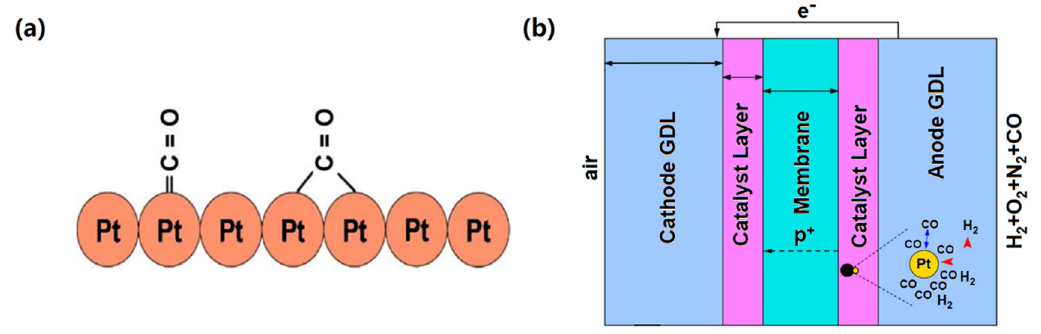
Figure 1. Sketch Map of ( a ) CO on Pt surface from Ref. [7] and ( b ) Anode catalyst layer in PEMFCs from Ref. [41].